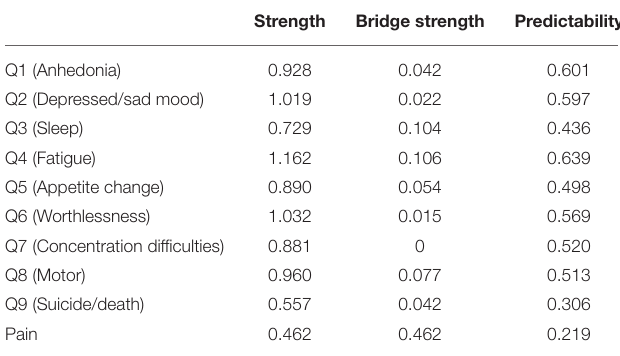
TABLE 1 | Centrality estimates of nodes in the network. Strength Bridge strength Predictability